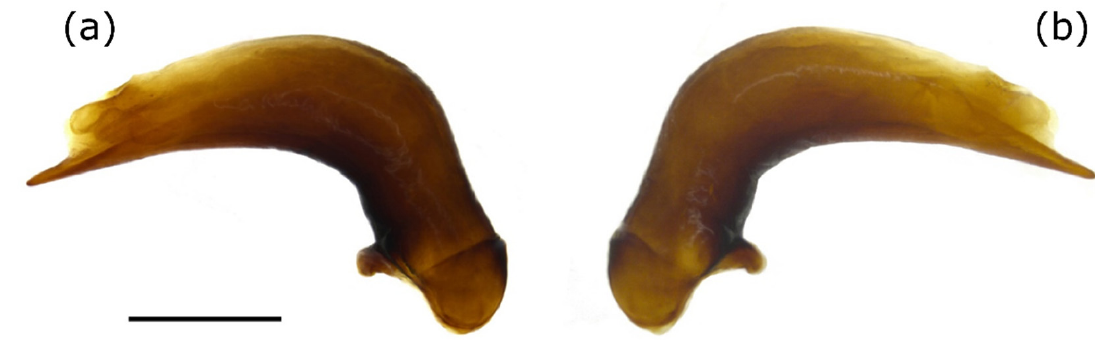
Figure 2. Median lobe of the aedeagus of Pterostichus adstrictus from the Taschachtal (Ötztal Alps, Austria), ( a ) right lateral view, ( b ) left lateral view, scale bar = 1 mm.